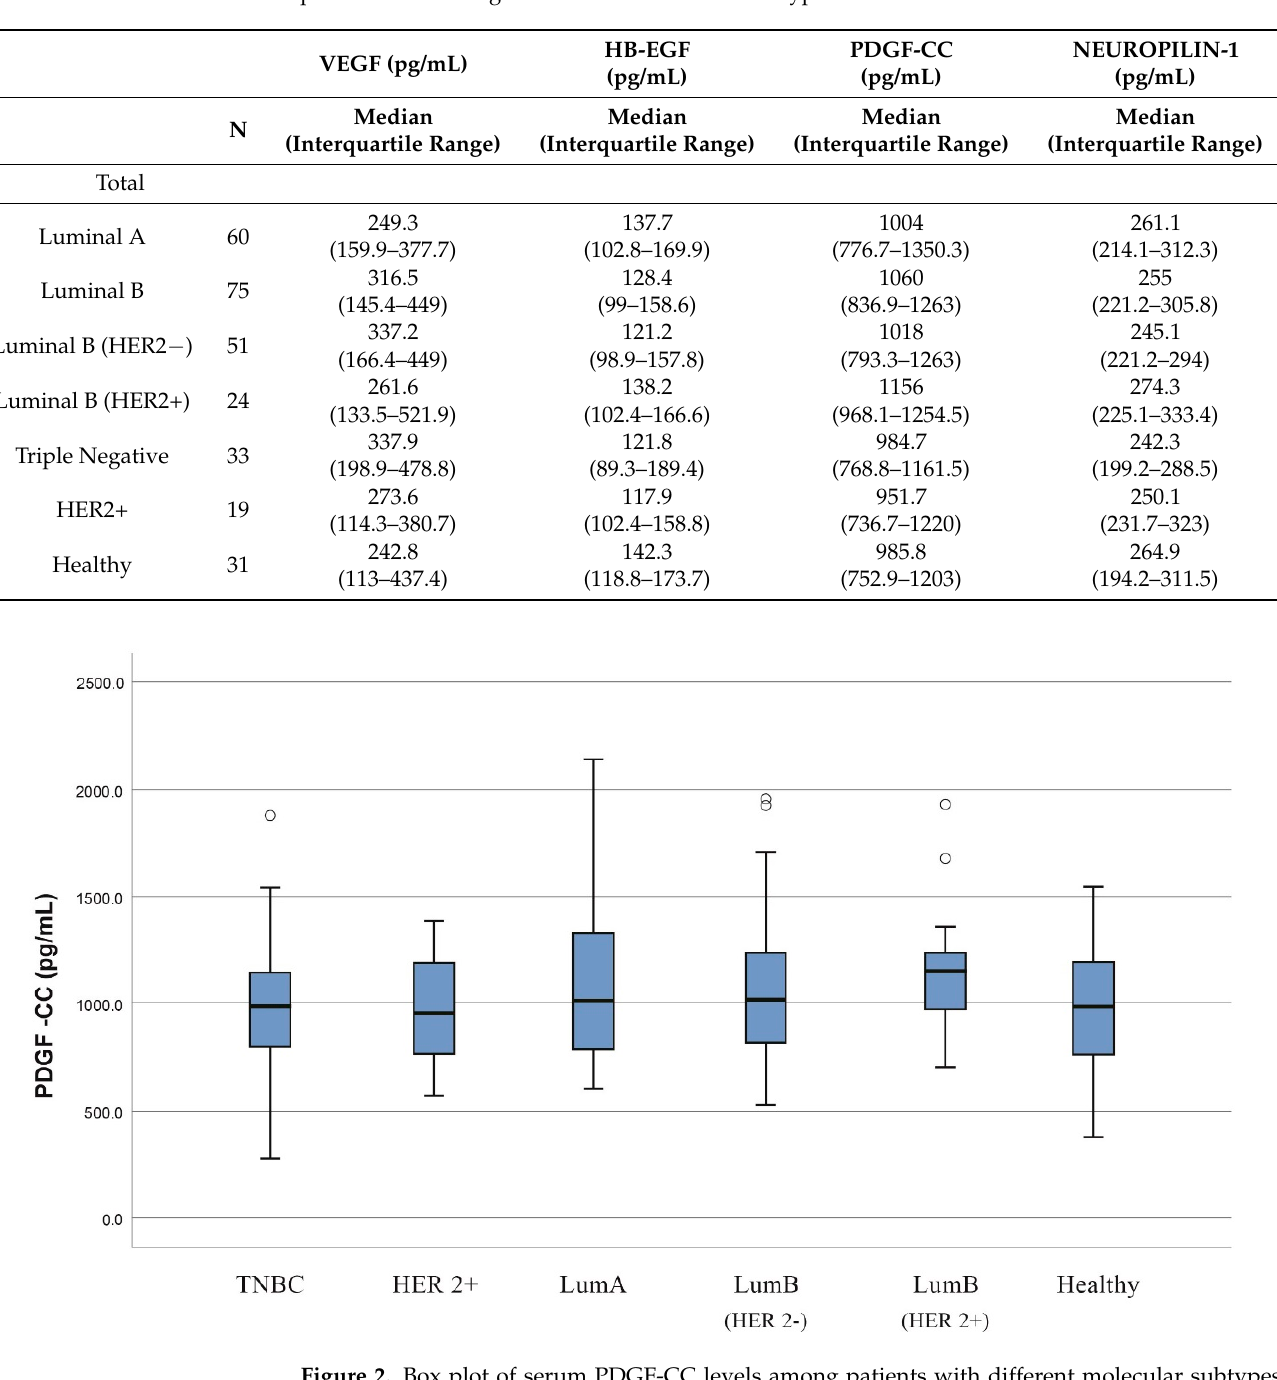
Figure 2. Box plot of serum PDGF-CC levels among patients with different molecular subtypes. Serum PDGF-CC levels are significantly lower in TNBC patients compared to Luminal B (HER2- negative) patients ( p = 0.031).